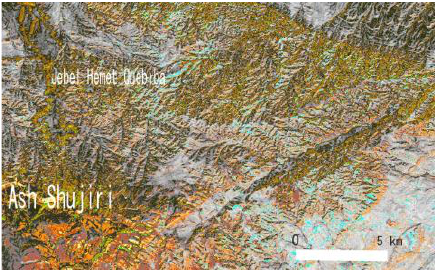
Figure 14. Zooming in on the study area interpreted with a cluster analysis on the Landsat-7 ETM at the village of Ash-Shujiri on Jebel Bishri. Grazing potential in this area is clearly visible in green areas. Cluster analysis by M. Törmä 2010.